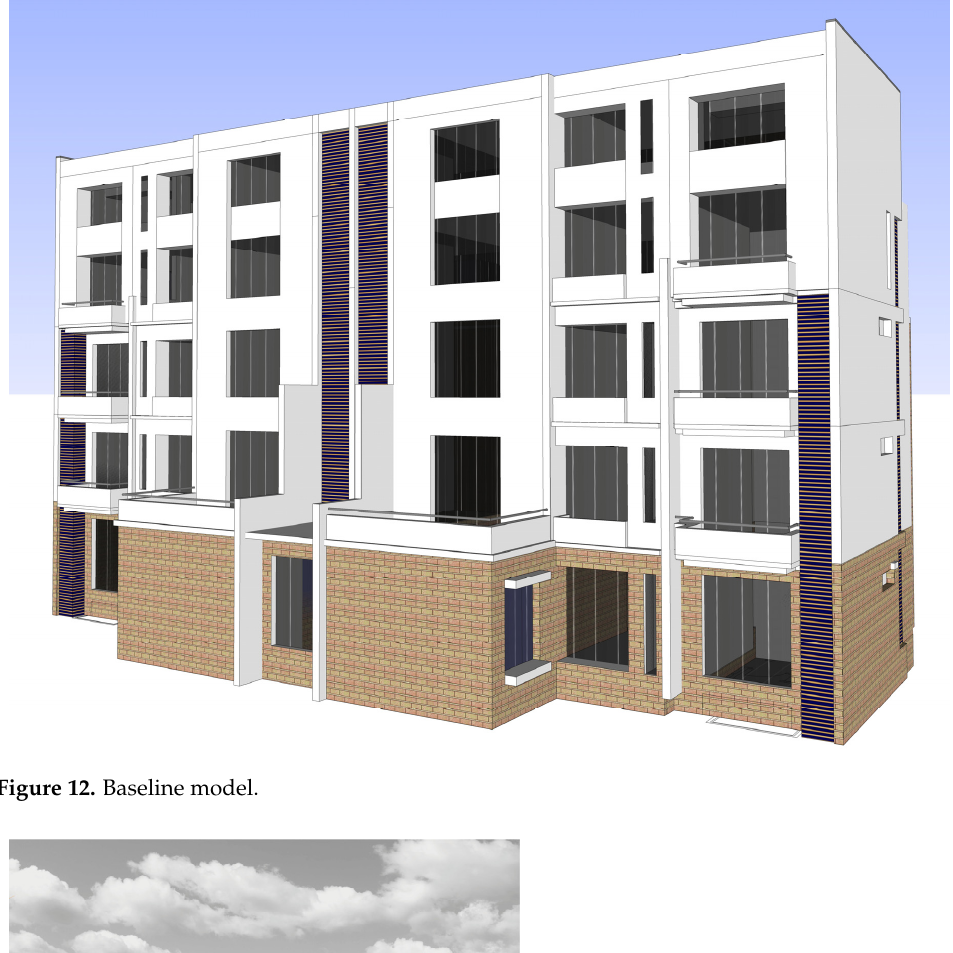
Figure 12. Baseline model.